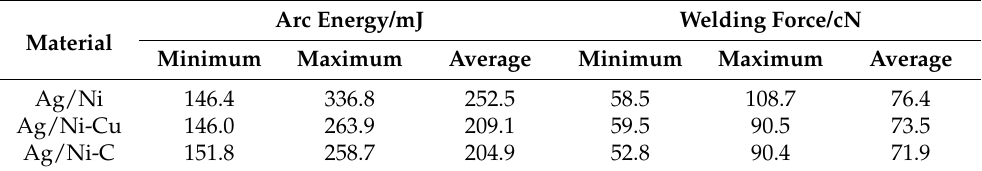
Table 6. Arc energy and welding